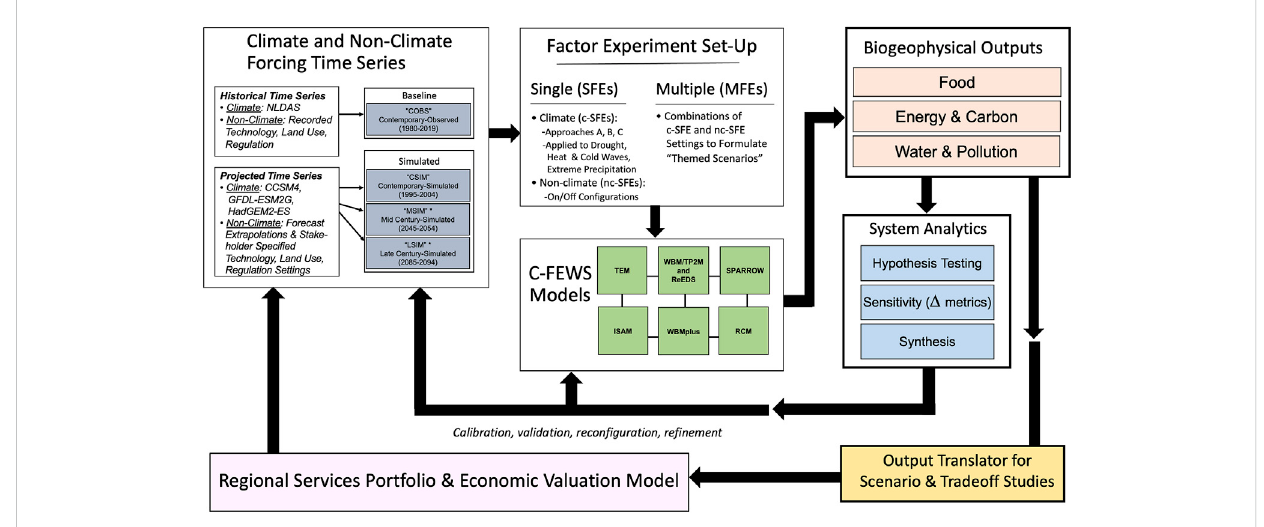
FIGURE 2 Computationalwork fl owforthesingle factorandmulti-factorexperiments,SFEsand MFEs,respectively. Studiesreported inthispaperfocusonthe historical timeframe (1980 –